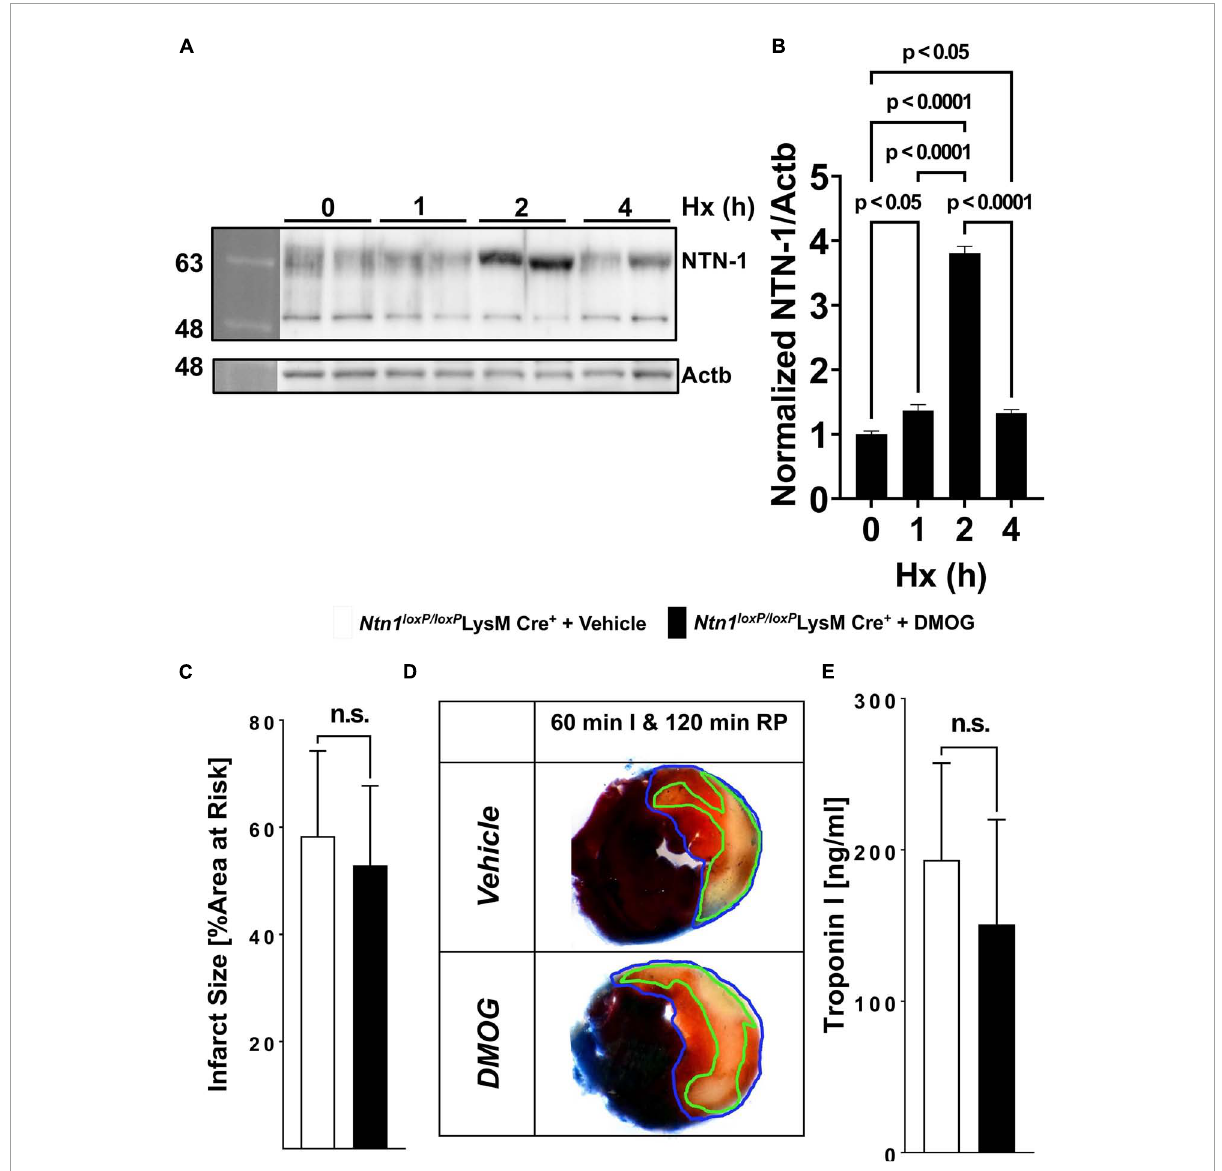
FIGURE6 Netrin-1 as a PMN-dependent Hif1A target critical for HIF-dependent cardioprotection. (A,B) Isolated human PMNs from healthy donors underwent hypoxia for 0, 2 and 4 h followed by cell lysis and total protein harvest. (A) Immunoblot for NTN1. b-Actin (Actb) served as the loading control. One representative blot of three experiments is shown. (B) Quantitation by densitometry of the NTN1 immunoblot results relative to b-Actin ( n = 2 per group; per group mean ± SD; compared by one-way ANOVA followed by Tukey’s multiple comparison test). (C–E) Ntn-1 loxP / loxP mice were crossed with Cre recombinase-expressing mice under the control of the lysozyme 2 promoter (LysM Cre+) to generate mice deficient in myeloid-specific Ntn-1. Mice received vehicle or 1 mg DMOG 4 h prior to ischemia, then underwent 60 min of